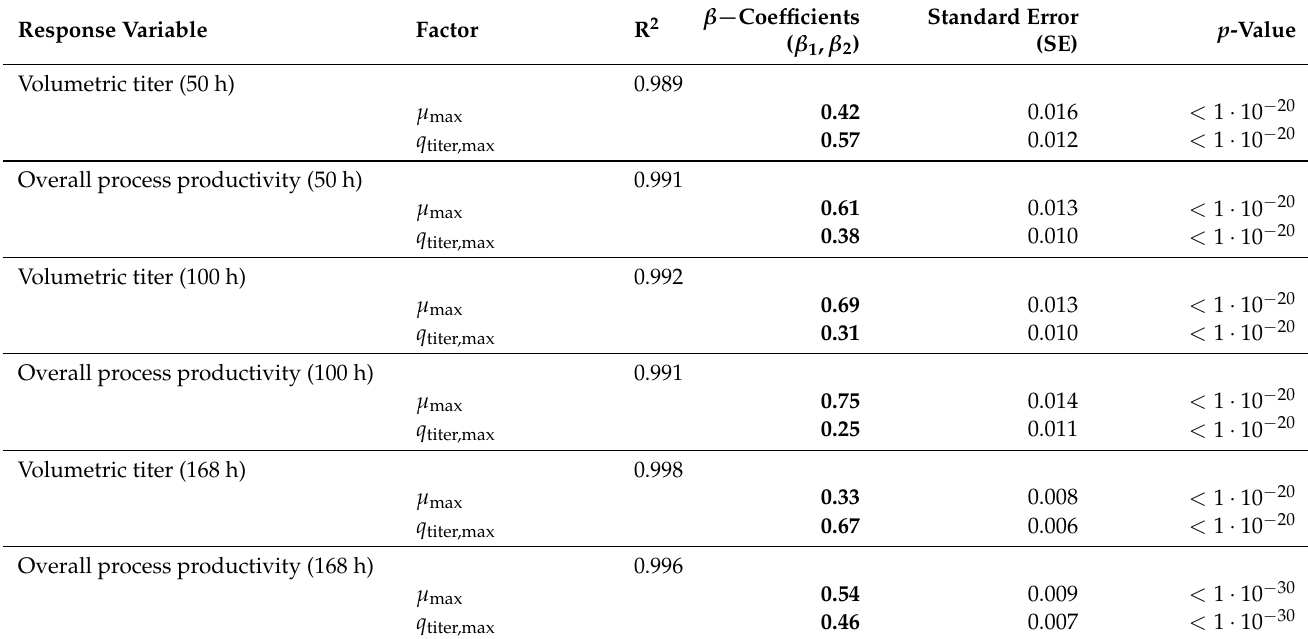
Table 7. Results of a multiple linear regression (R 2 , β -coefficients, standard error (SE) and p -value) in two variables, maximum growth rate µ max (coefficient β 1 ) and maximum production rate q titer,max (coefficient β 2 ) at 50, 100 and 168 h of production. Response values are volumetric titer in production and overall process productivity (=Space-Time-Yield: volumetric titer in production/overall cultivation time, including inoculum